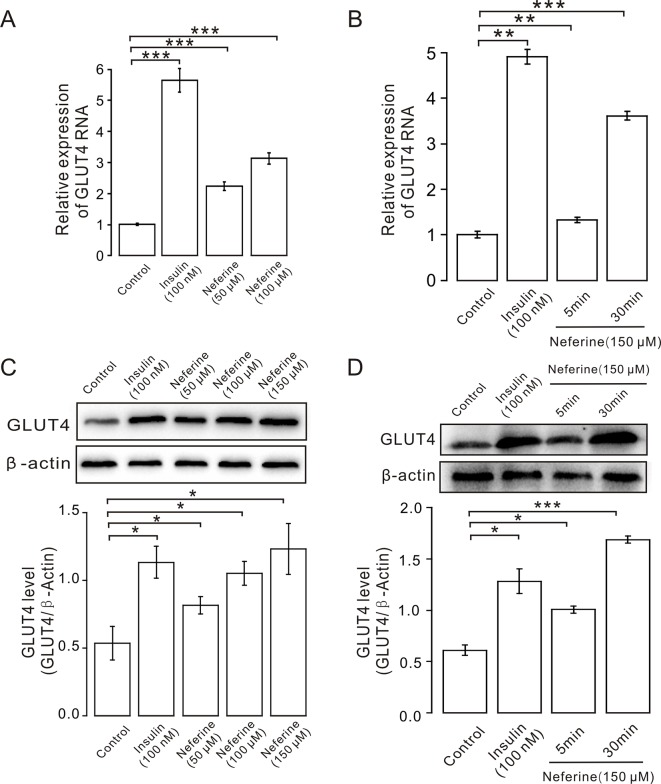
Neferine enhances GLUT4 mRNA and protein expression in L6 cells. (A) GLUT4 mRNA expression in L6 cells detected using real-time PCR shows significantly increased mRNA expression in L6 cells in 100 nM insulin, as well as 50 μM, and 100 μM neferine. (B) GLUT4 mRNA expression in L6 cells 5 and 30 min after treatment with 150 μM neferine. (C) Western blot analysis of GLUT4 protein expression; neferine-induced GLUT4 expression is dose-dependent. (D) Effects of 150 μM neferine on GLUT4 protein expression 5 and 30 min after treatment. *P < 0.05; **P < 0.01; ***P < 0.001.